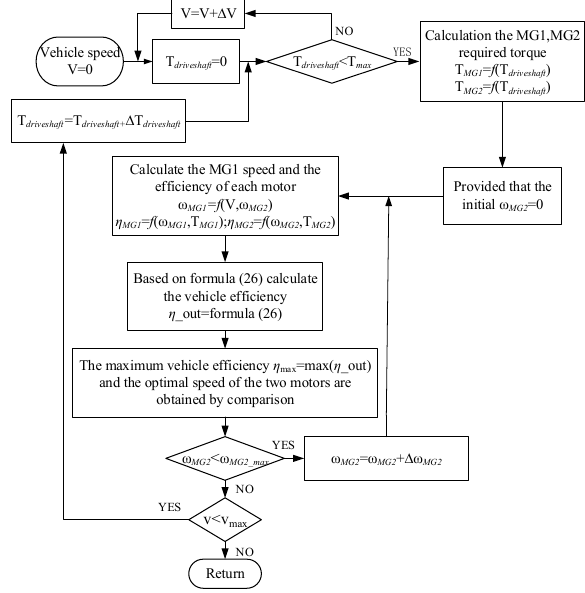
Figure 5. Flow chart for obtaining optimal speed of dual motor.